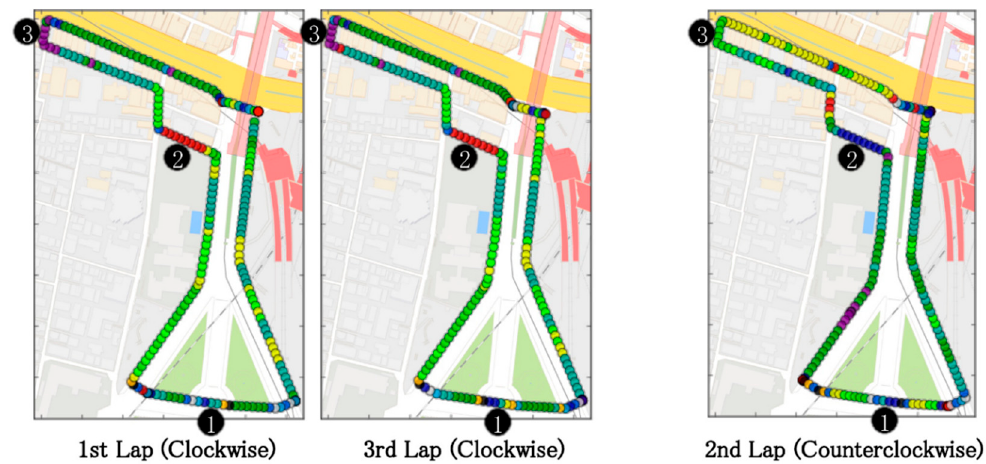
Figure 6. The clustering result of the DCNN feature output of E1 ′ s acceleration data in 14 clusters.